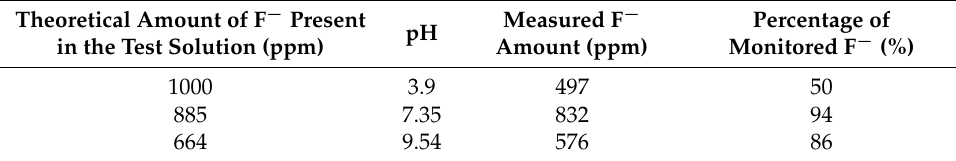
Table 1. Fluoride content dependence on changes in